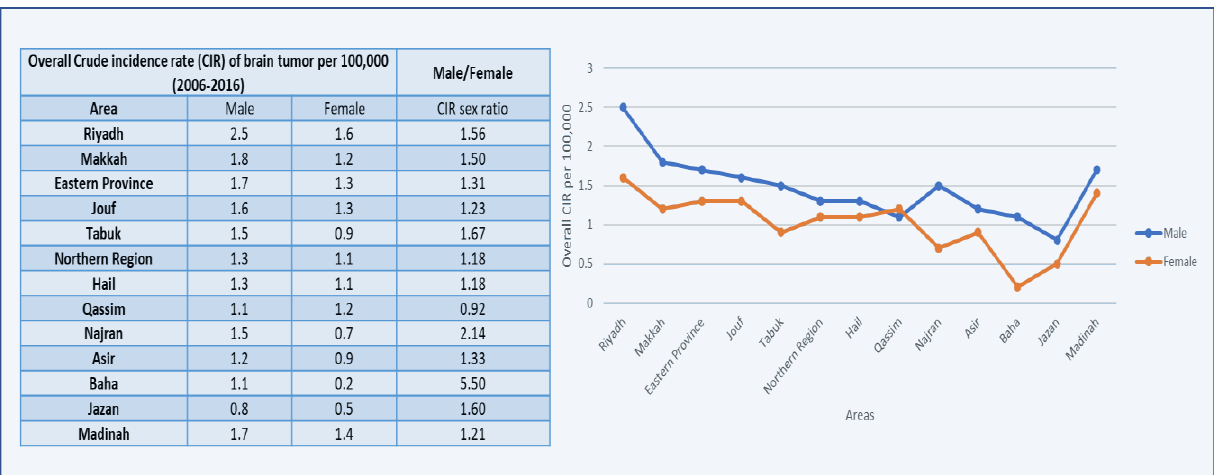
Figure 3. Overall CIRs of brain tumor cases per 100,000 between males and females according to administrative areas from 2006 to 2016.